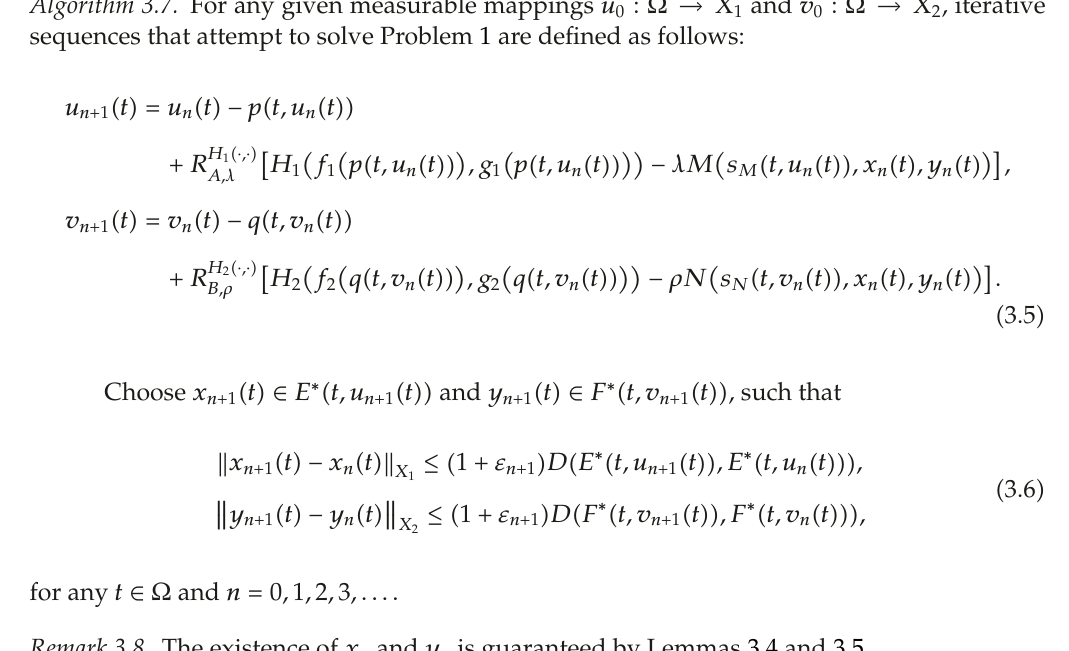
Algorithm 3.7. For any given measurable mappings u 0 : Ω → X 1 and v 0 : Ω → X 2 ,